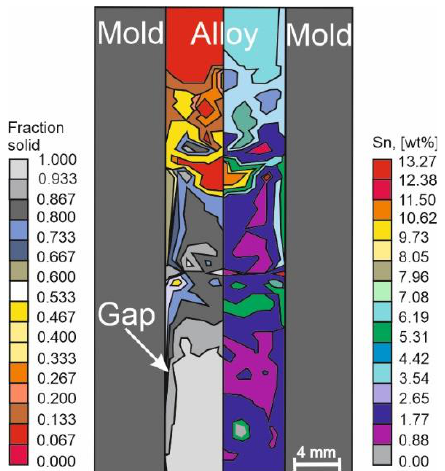
Figure 18. SEM image of GCGs in the microstructure of Cu-Sn alloy after TZCC [34]. Microstructural investigation using an optical microscope and the EBSD technique by Luo et al. [36] proved that initial nucleation of small grains resulted in the front of the solid–liquid interface region during TZCC. The angular difference between [0 0 1] columnar grains and the direction of heat flow was found to be less than 19 ◦ , which was attributed to the faster growth rate. Similarly, the slower growth rate for small grains was because of the magnitude of the angle exceeding 19 ◦ between [0 0 1] small grains and the direction of heat flow. When both columnar and small grains were in contact, the growth of columnar grains was more pronounced when compared to small grains. This led to the formation of GCGs and much smaller grains at the grain boundaries of columnar grains. Microstructure and its quantification have been well-explained by Luo et al. [36] after the TZCC process. Finally, Luo et al. [37] made use of ProCast software that simulates the TZCC process to analyse solute (Sn) distribution and surface segregation taking place along the process. Cu-4.7 wt%Sn alloy with a broader solid–liquid phase zone was under investigation. Figure 19 shows that the solidification of the alloy was first found at the centre and initiated the ‘ Λ ’ structure. Moreover, a narrow gap was formed between the solid/liquid interface and a wall in the two-phase zone mould was created. This formation of the gap was attributed to the formation of the ‘ Λ ’ structure. The alloy solidified along the direction opposite to the direction of continuous casting. SEM analysis revealed that redistribution of Sn solute occurred, which was the reason for the solid grain nucleation near the walls of the two-phase zone mould. Luo et al. [37] have also proved that the liquid enriched Sn solute caused by solid grain growth will increase the amount of Sn solute at the solid–liquid interface.